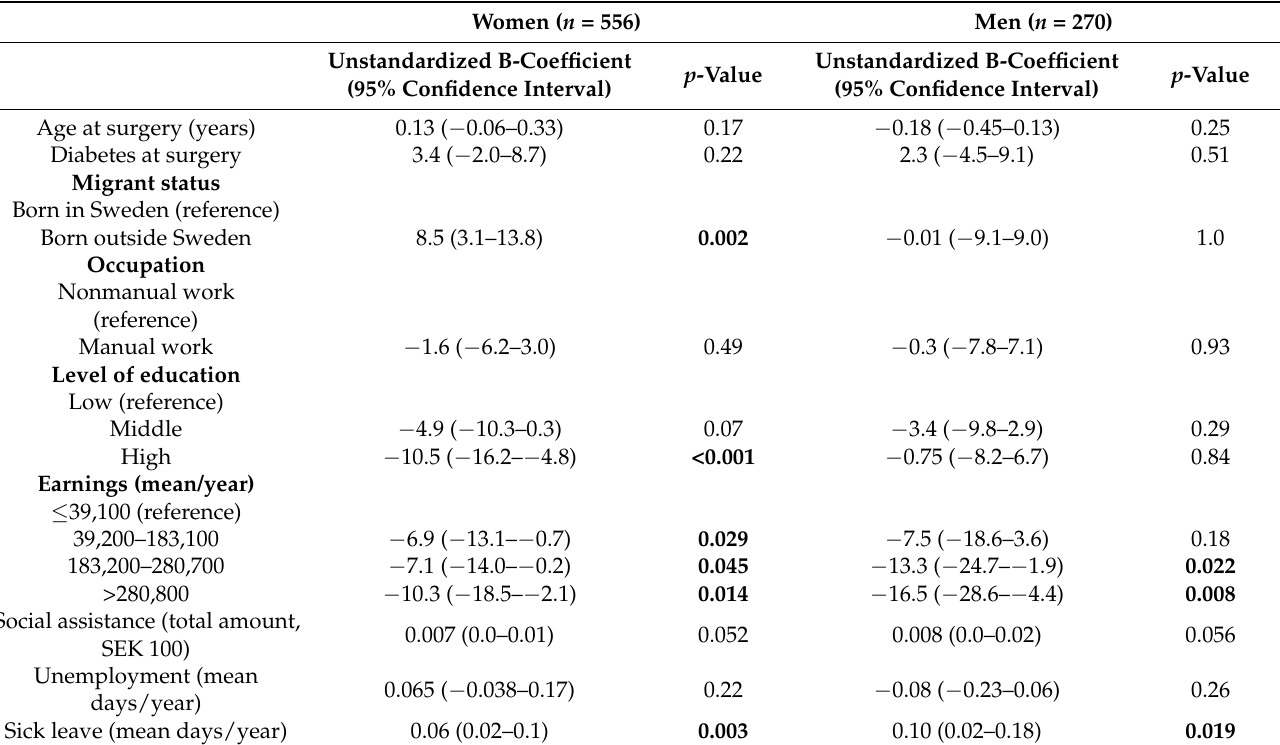
Table 2. Linear regression model for patients with surgically treated carpal tunnel